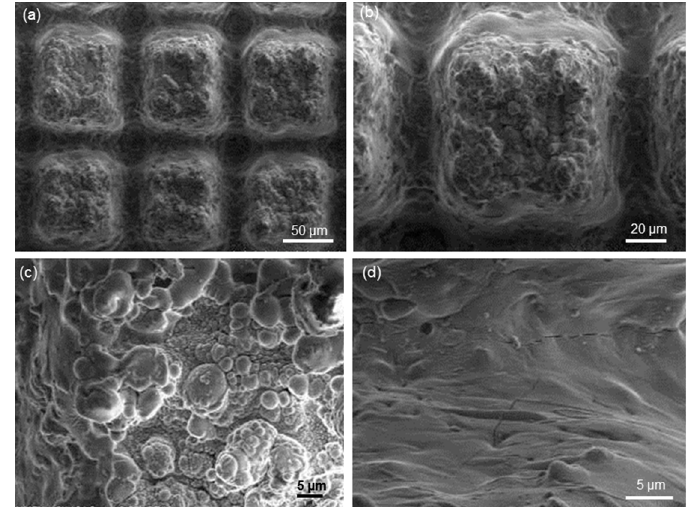
Figure 13. Relationship between surface roughness ( R a and R q ) and number of cycles used during the laser treatment.